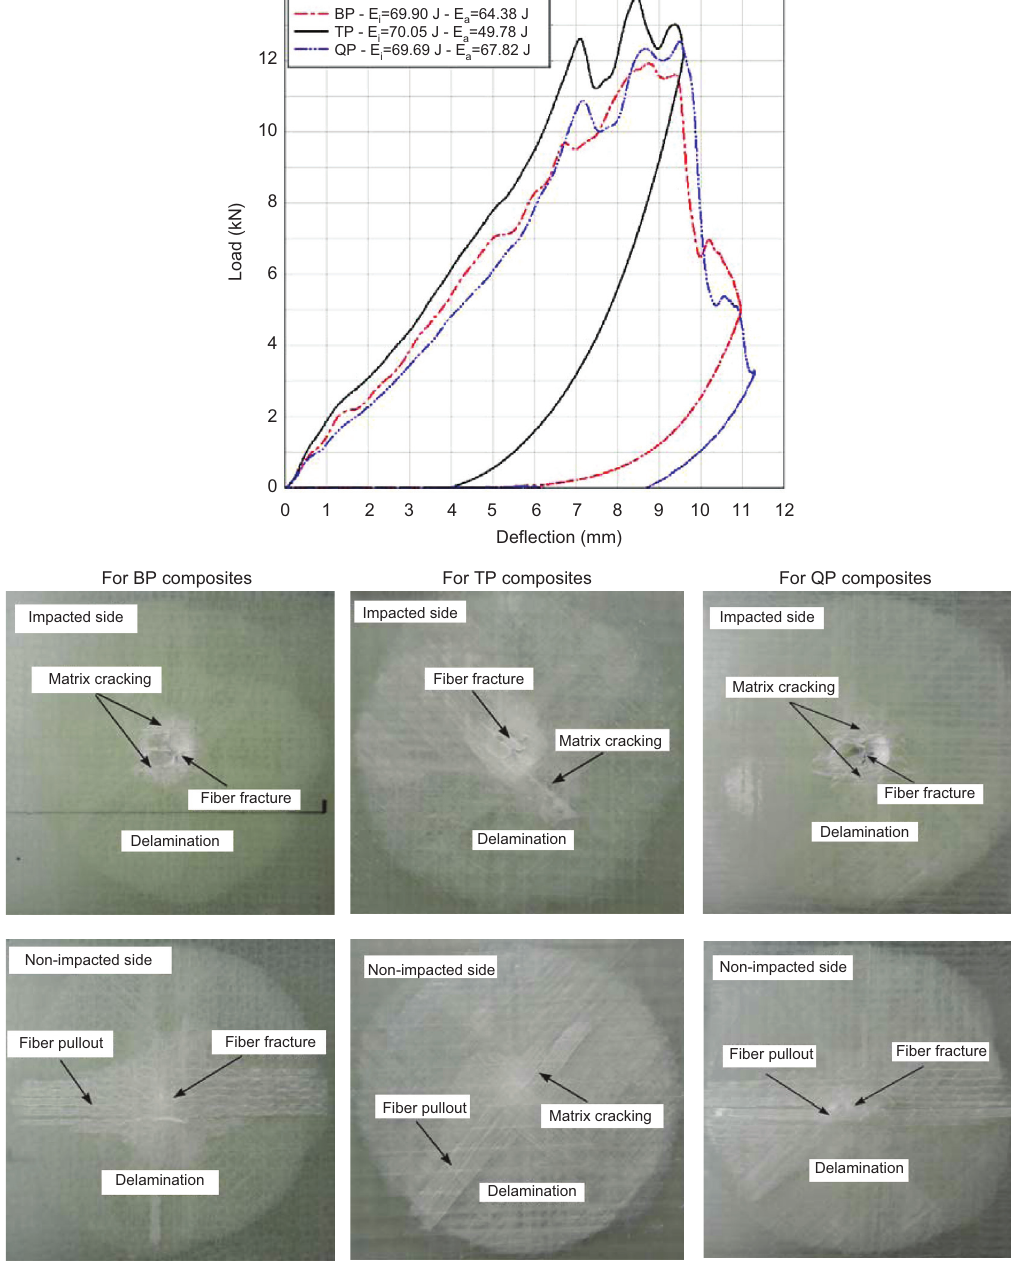
Figure 7 Typical load-deflection (F-d) curves of the BP, TP, and QP composites and images of damaged